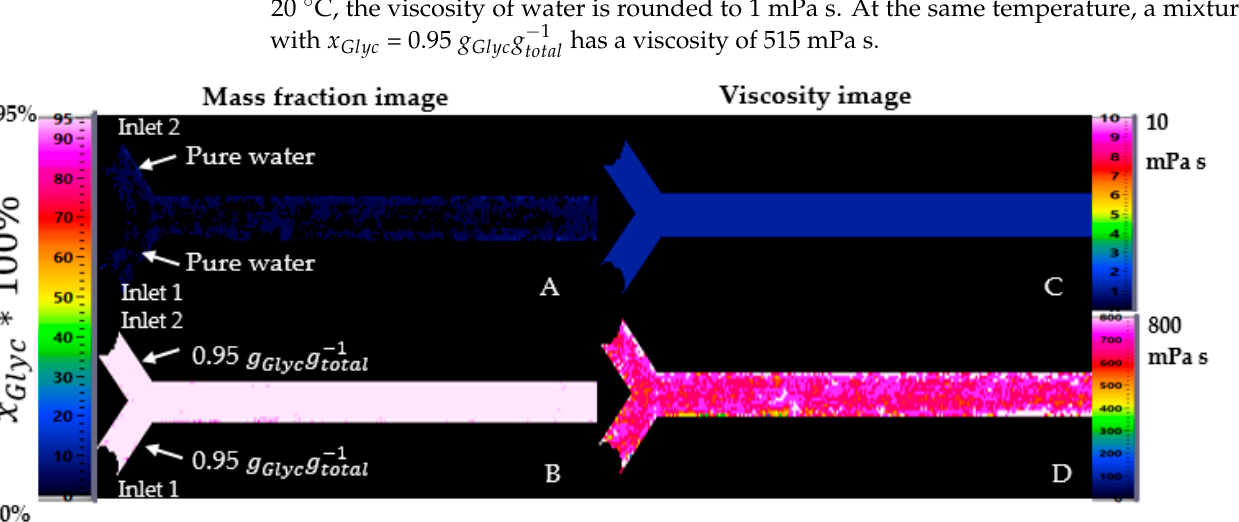
( B ) at 20 ◦ C and total